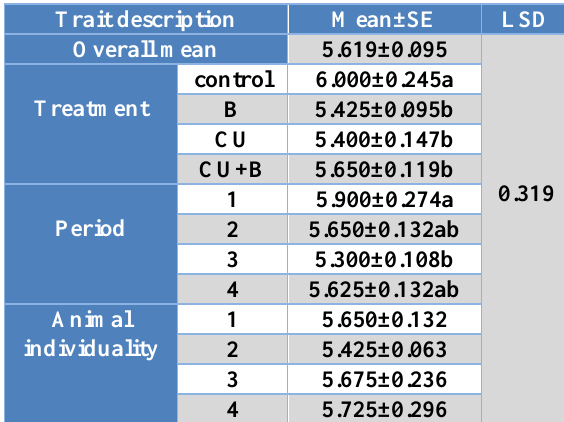
Table, 2: Effect of using Ocimum basilicum and/or Cuminum cyminum on rumen pH during different periods and Awassi ram individuality.